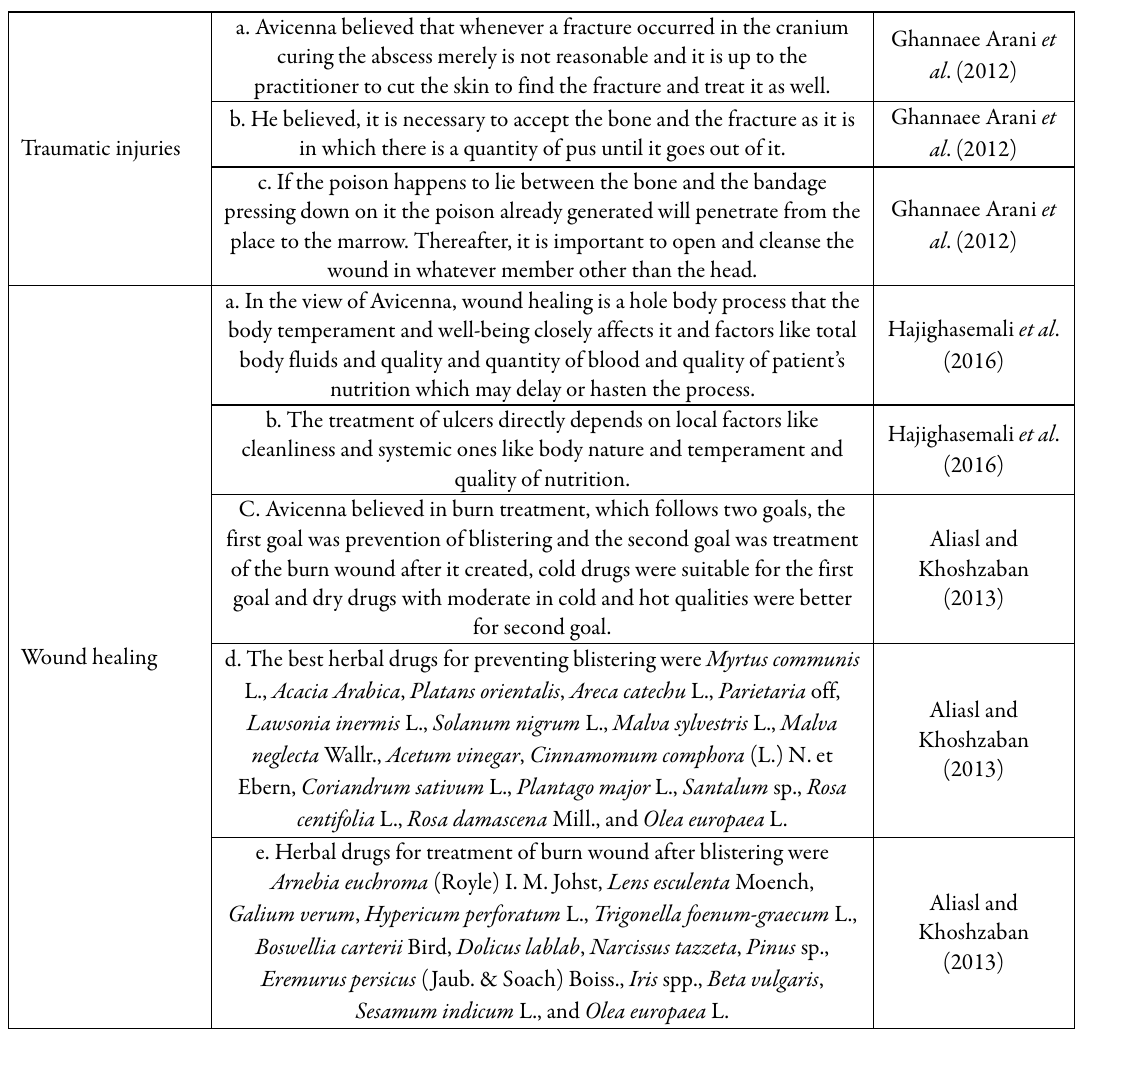
Table 6. Five most important sections of Canon of the